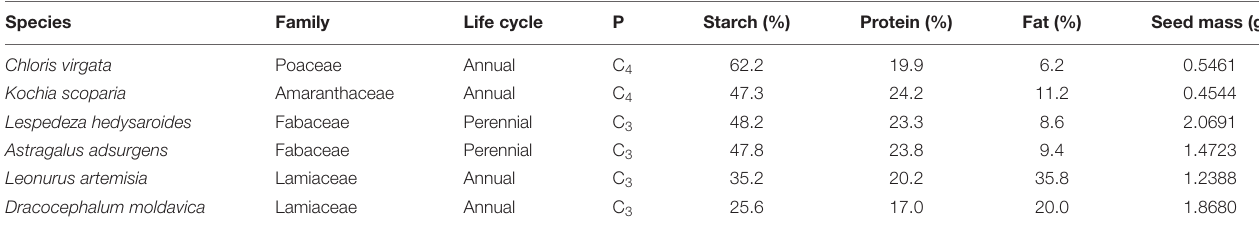
TABLE 1 | Family, life cycle, photosynthetic pathway (P), main seed reserve proportion in dry seeds and 1000 seed mass of the six species in this study. Species Family Life cycle P Starch (%) Protein (%) Fat (%) Seed mass